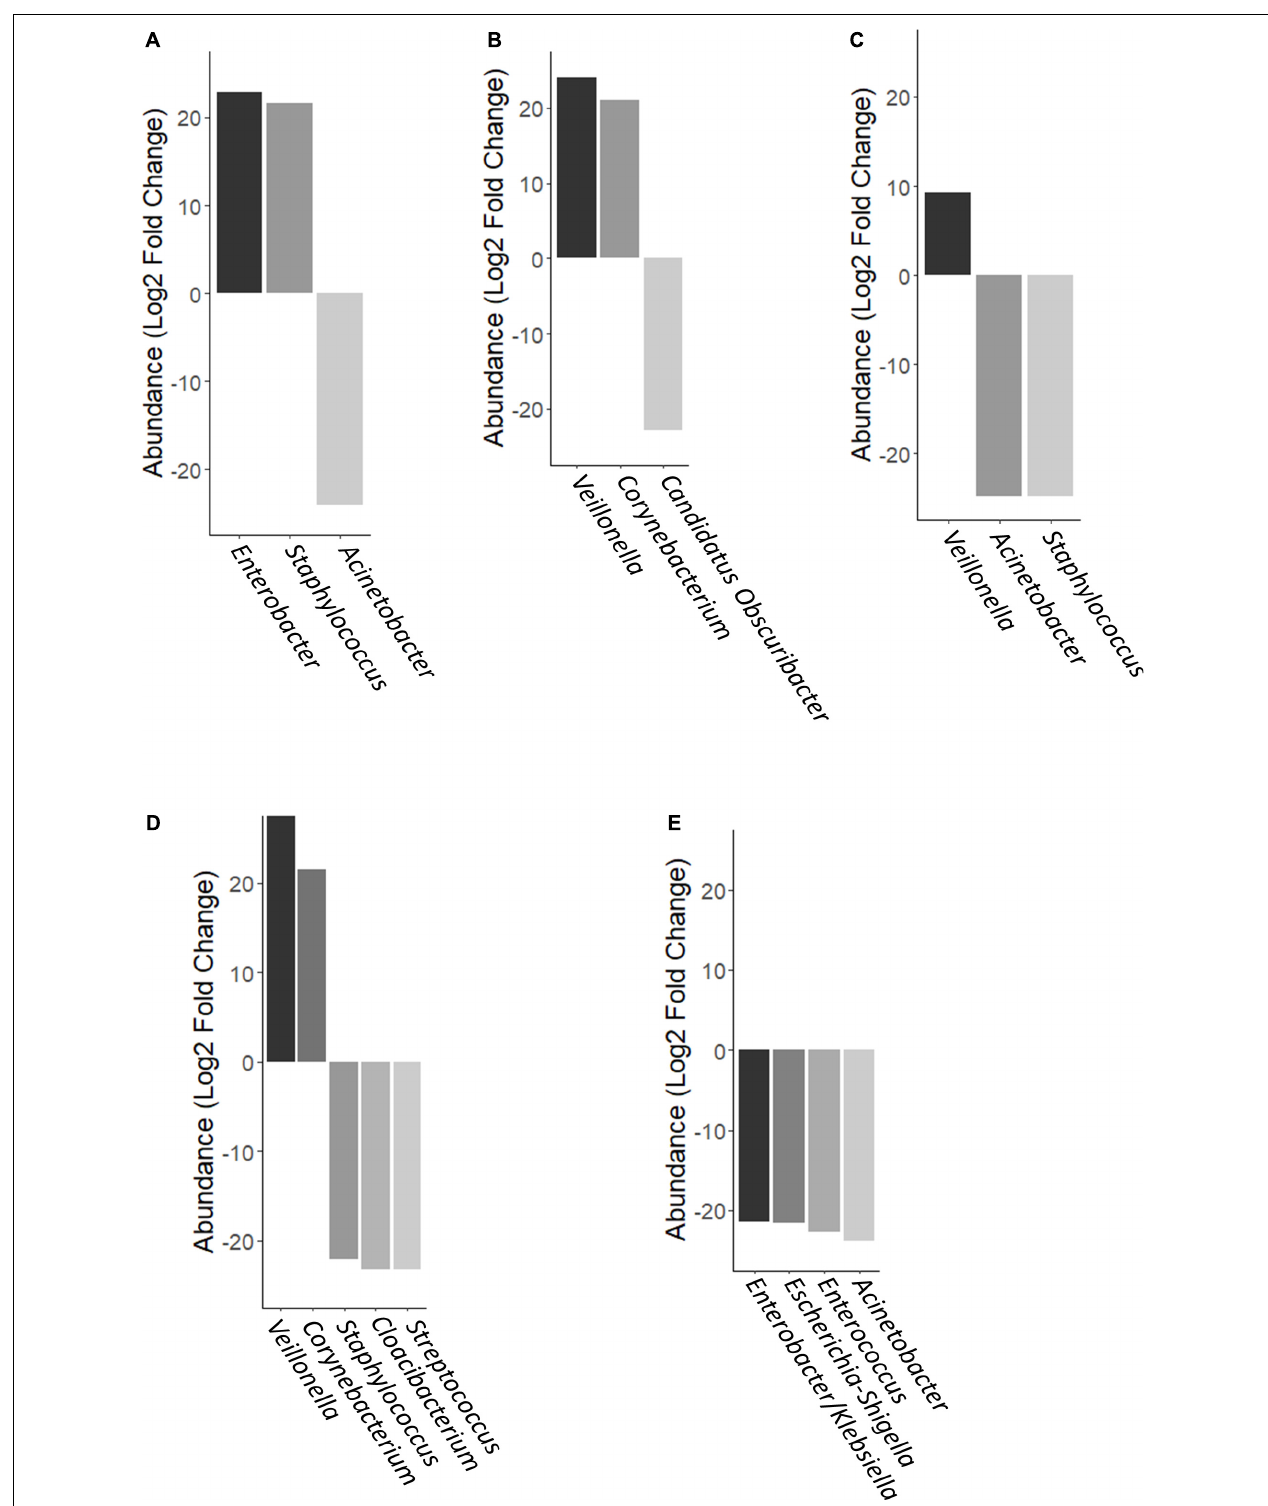
FIGURE 5 | Differential abundance of OTUs using DESeq analysis. (A) FMOM compared to MOM at 4 h (T4), (B) MOM and RM30 at T4, (C) FMOM and FRM30 at T4, (D) MOM and RM10 at T4, and (E) FMOM and FRM10 at T4.